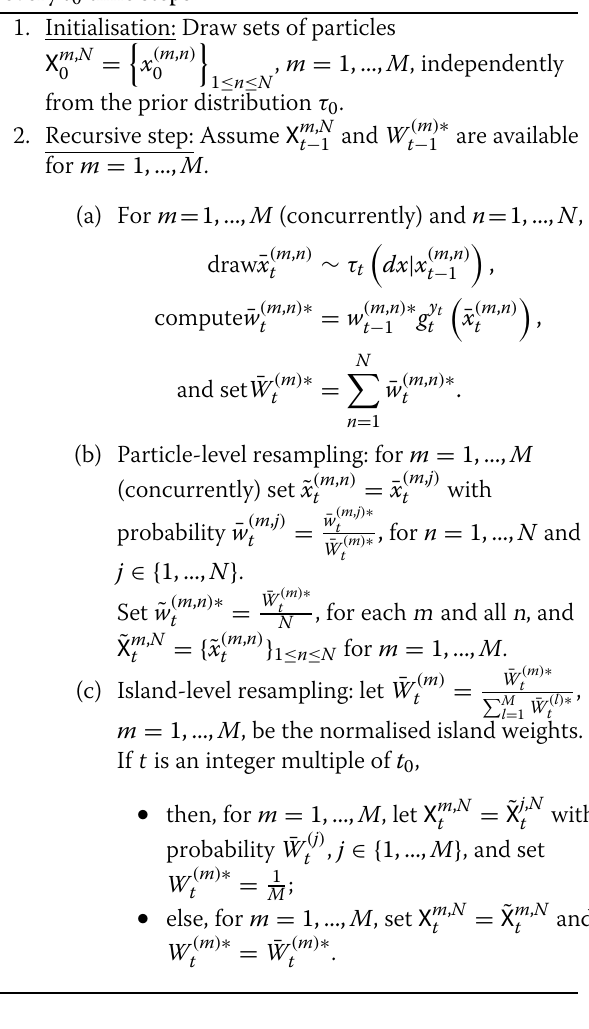
Algorithm 3: Double bootstrap filter with M islands and N particles per island. Island-level resampling every t 0 time